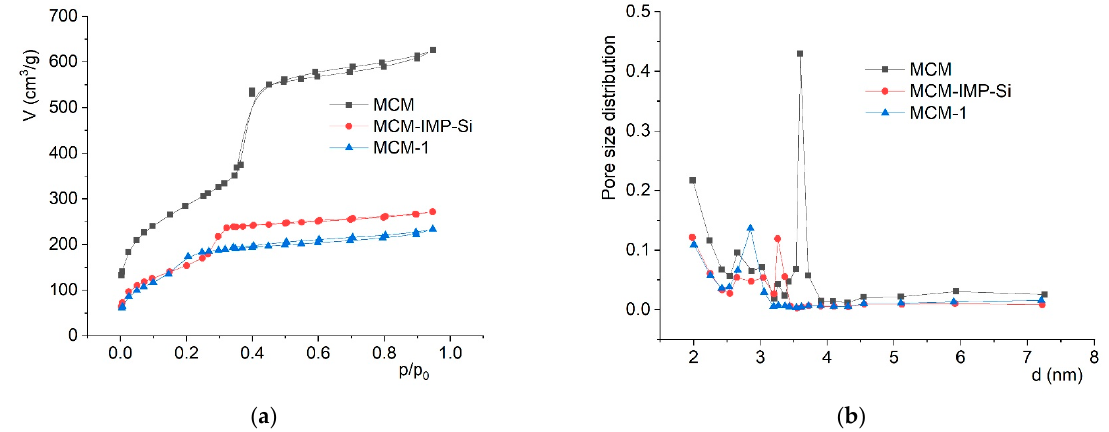
Figure 4. ( a ) Nitrogen adsorption isotherms at 77 K and ( b ) pore size distribution (PSD) curves of MCM, MCM-IMP, and MCM-1. Table 2. Textural parameters of host and composite materials from powder XRD and N 2 isotherms at 77 K, for all prepared materials.